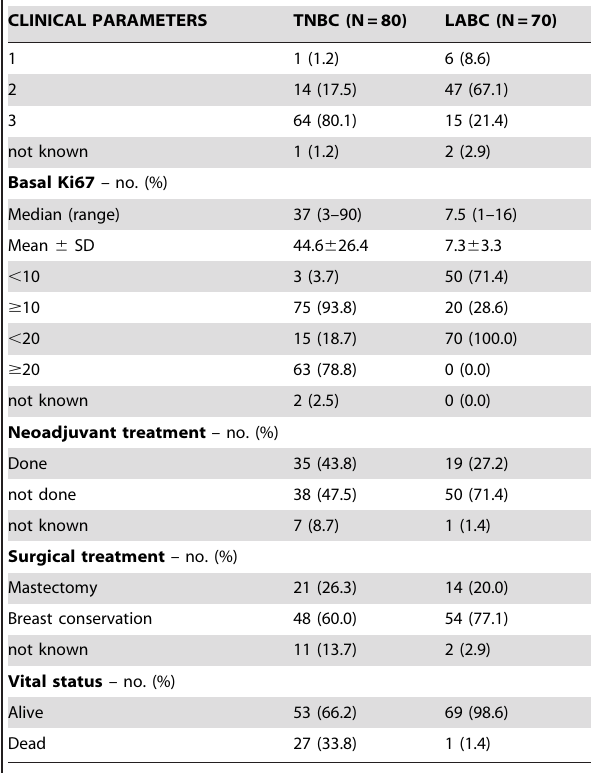
Table 1. Baseline patients’ demographic. Table 1. Cont.